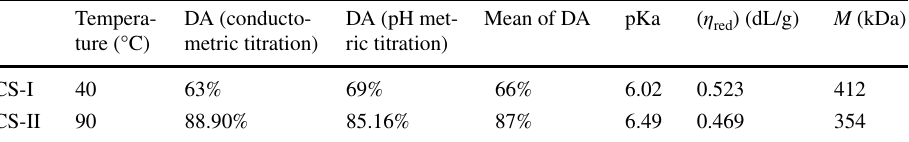
Table 2 Characteristics of the extracted CS from shrimp shell